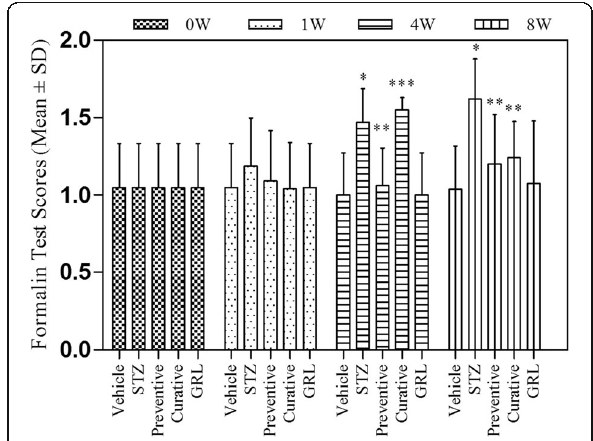
Fig. 2 Effects of GRL on nociceptive response. Histogram shows the levels of nociceptive response in all groups. Values are mean ± SD of 7 rats/group. * P < 0.001 versus vehicle and GRL group; ** P < 0.001 versus STZ group; *** P < 0.001 versus Preventive group by one-way ANOVA followed by Tukey ′ s post-hoc tests and two-way ANOVA followed by Bonferroni ’ s post-hoc tests